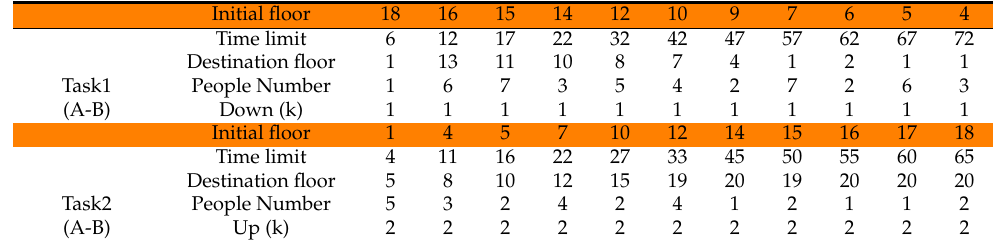
Table 3. Reservation tasks in the low area transported by